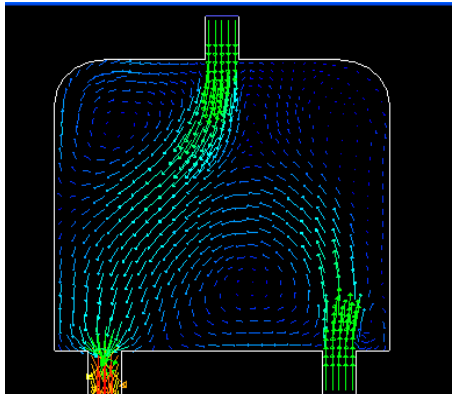
Figure 9. The distribution of water flow